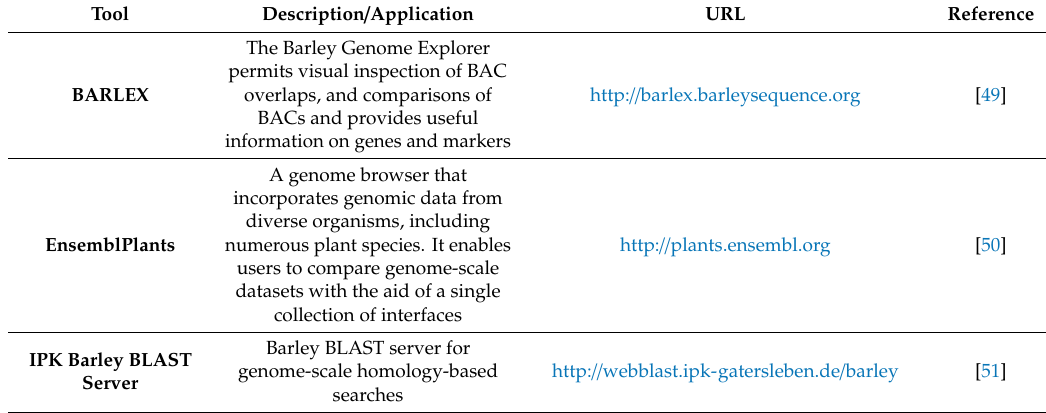
Figure 1. Overview of the genetic characteristics and genomics tools available for barley. These features, together with its canopy architecture and developmental properties, make barley an optimal model for chloroplast research. Table 1. List of databases, genome browsers and bioinformatics tools available for barley genome analyses.